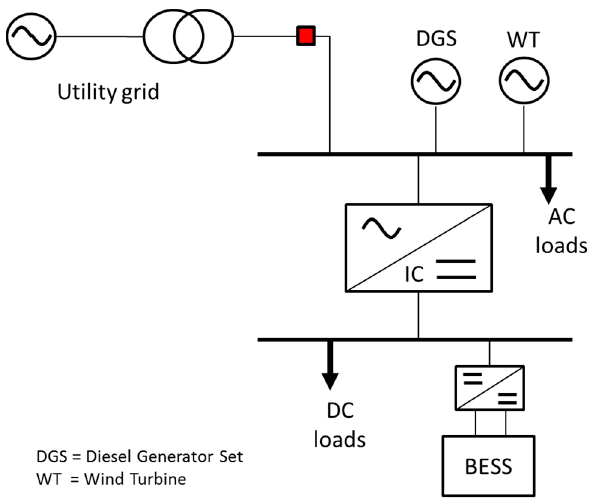
Figure 1. Hybrid AC/DC microgrid model. IC, interlink converter; BESS, battery energy storage system.